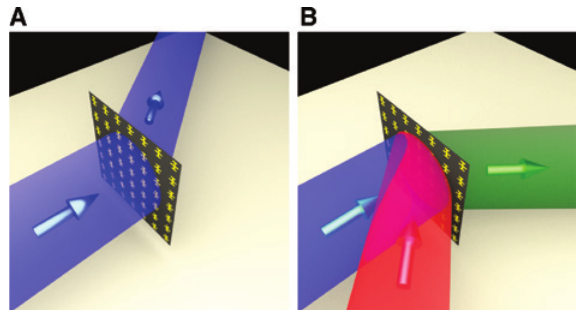
Figure 12: Example of a remote spatial processing operation: (A) signal beam being refracted by the metasurface and (B) superposi- tion of signal and control beams interacting with each other, which leads to a different transmitted wave.